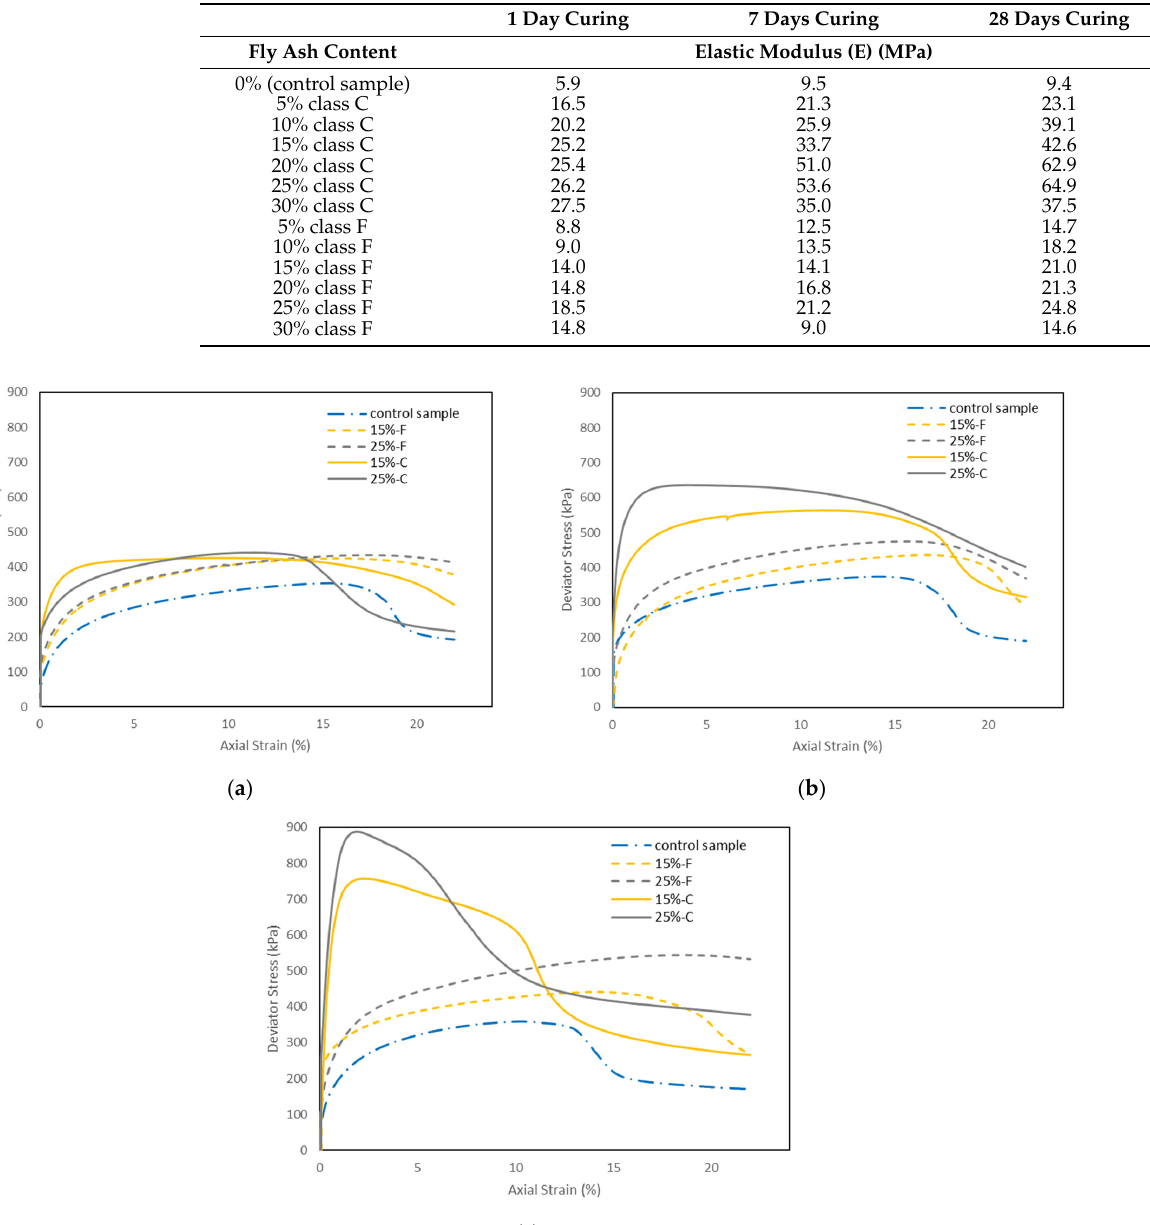
Table 3. Elastic modulus of class C and class F fly ash stabilized soil from UCS tests with different curing times.